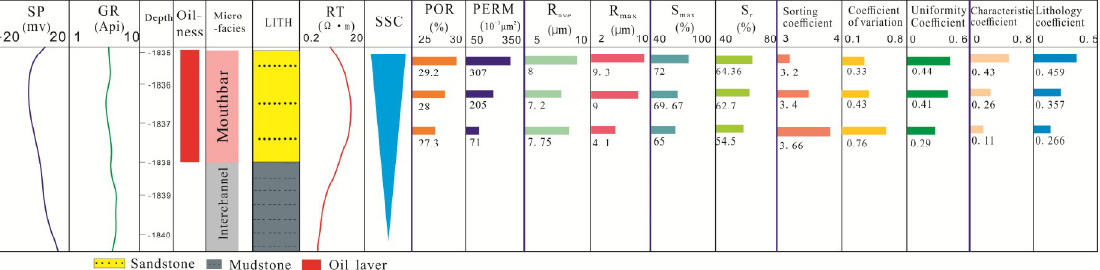
Figure 12. Pore structure of the samples in SSC3 (Well Guan51-7).